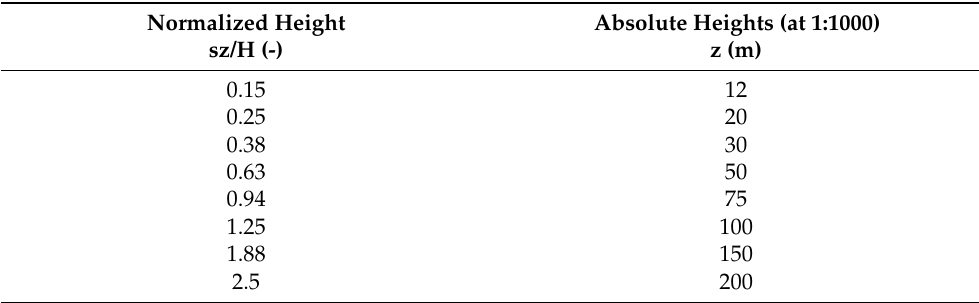
Table 1. Measurement heights above local ground level in normalized (z/H) and absolute (z) coordinates. Absolute heights are presented for a model scale of 1:1000.